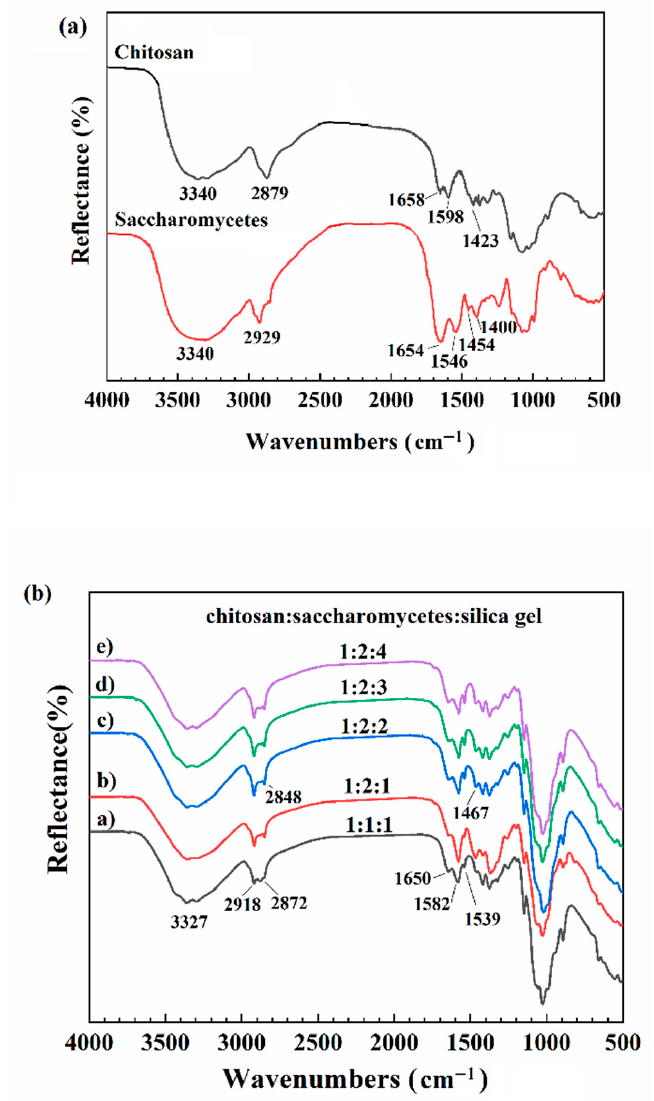
Figure 2. FTIR spectra of chitosan powder and saccharomycetes powder ( a ), and porous chi- tosan/saccharomycetes microspheres with different ratio of chitosan to saccharomycetes and silica gel ( b ).